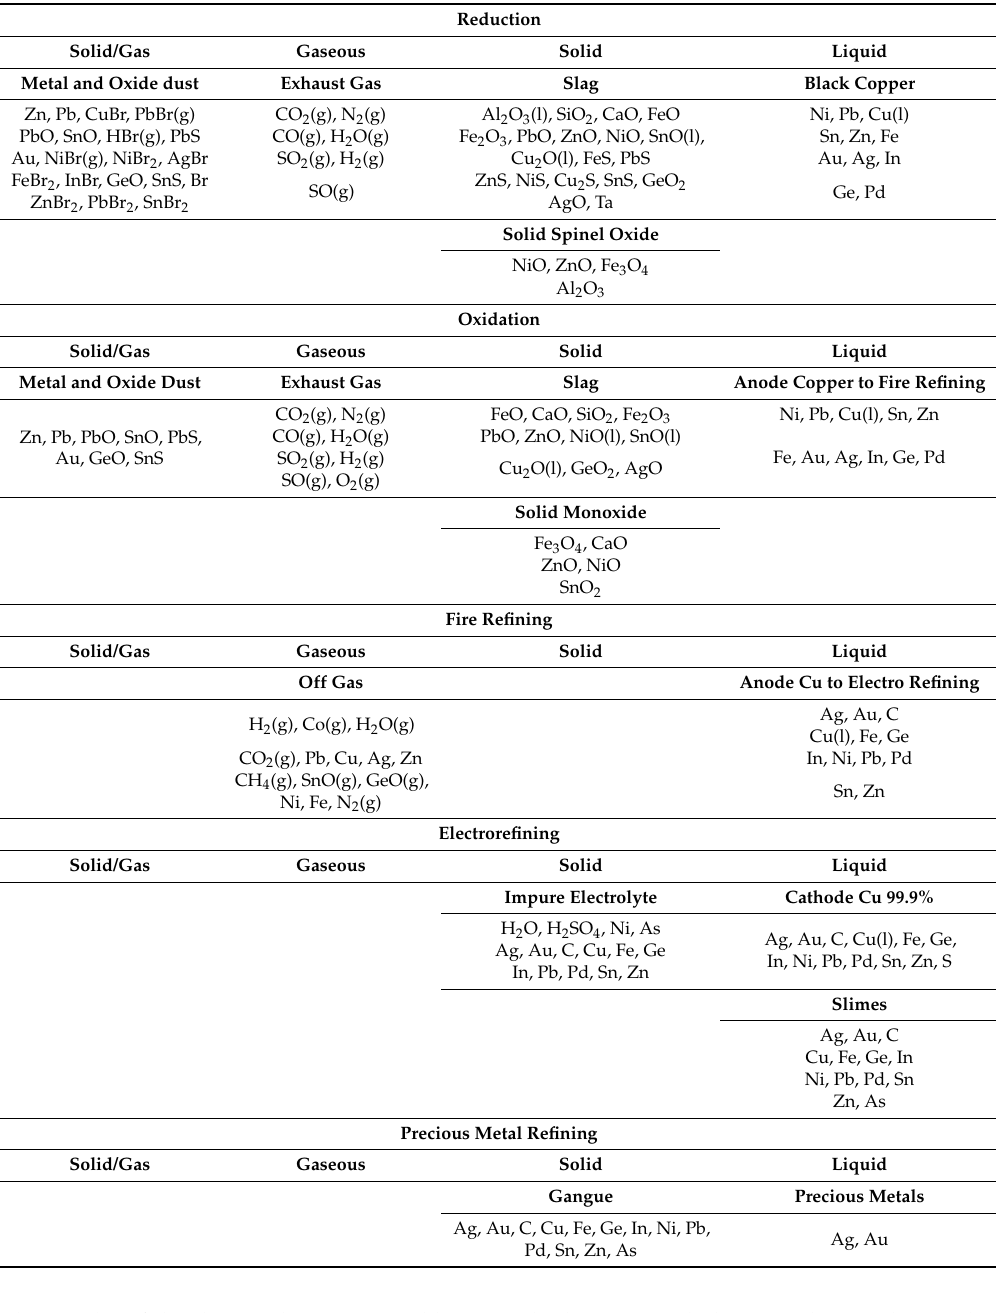
Table 3. Distribution of elements between different